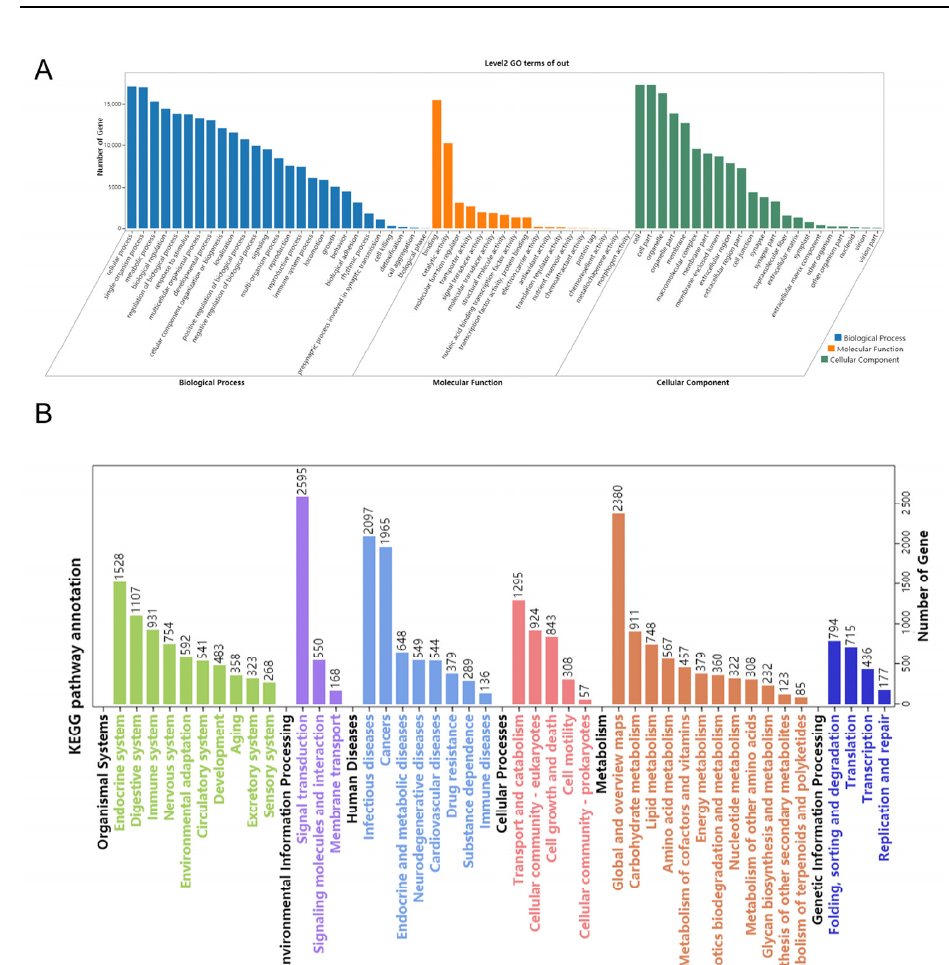
Figure 8. Gene ontology (GO) ( A ) and KEGG pathway ( B ) classifications of the 30,172 non-redundant putative target transcripts of the eight validated ovary- or testis-biased miRNAs.